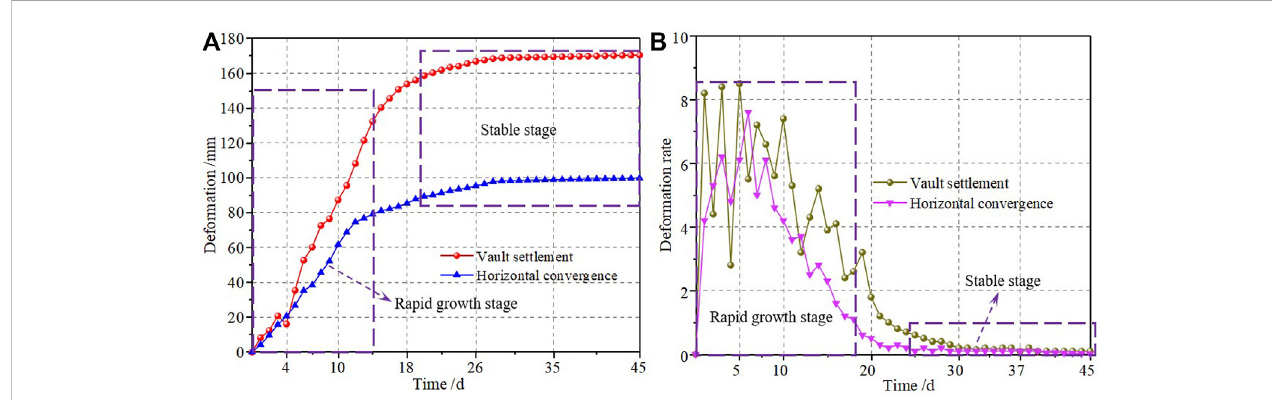
FIGURE 5 Result of surrounding rock deformation: (A) cumulative deformation curve and (B) deformation rate curve.